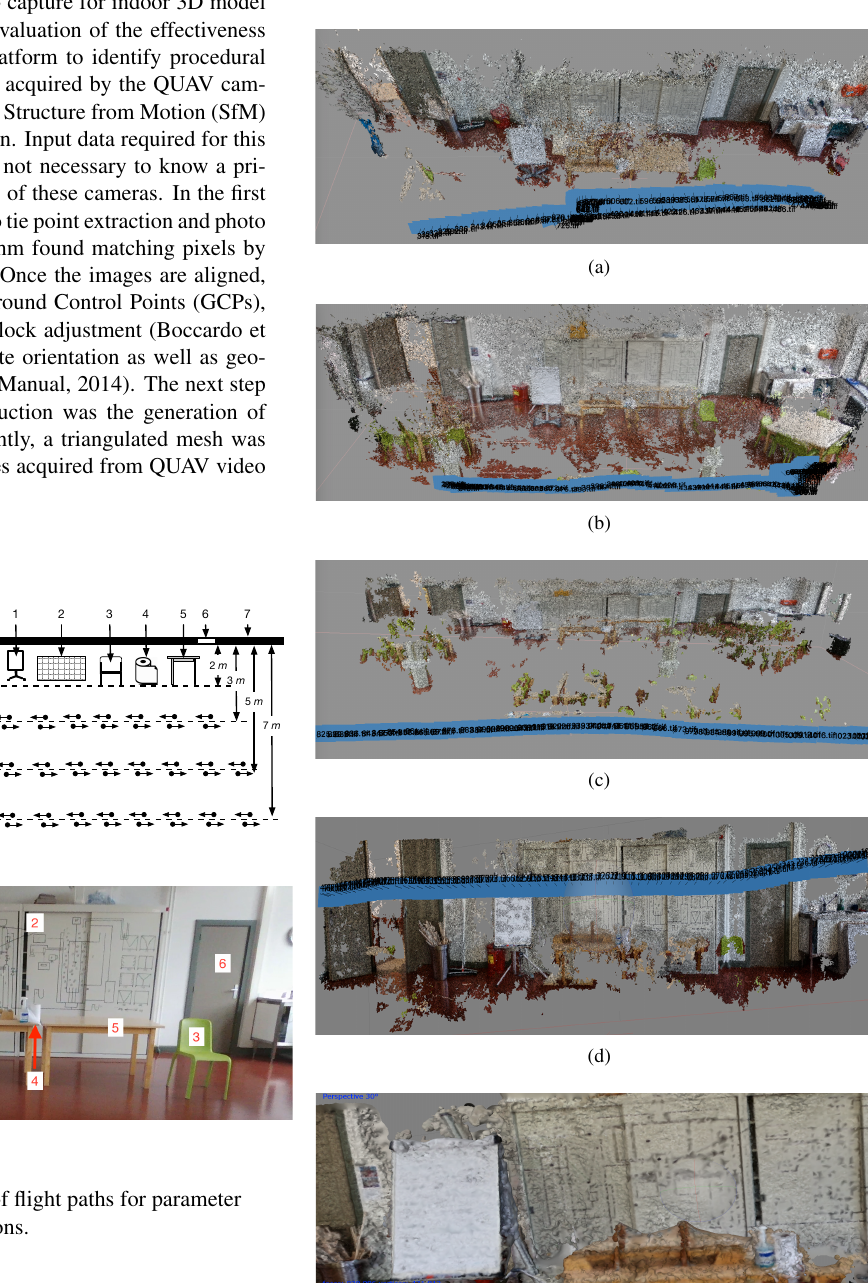
Figure 8. Dense Point clouds with aligned photos from parameter estimation experiments. Eight flight paths collected data at distances of three, five and seven meters between the QUAV camera and the wall. We